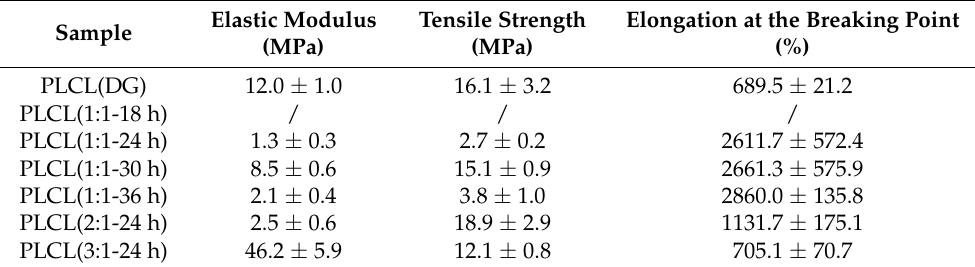
Table 3. Elastic properties of PLCL (DG) and PLCL (1:1 - 30 h).